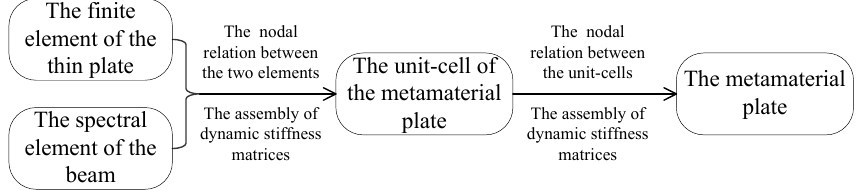
Figure 2. The analysis steps of dynamic stiffness matrix of the metamaterial sandwich plate.